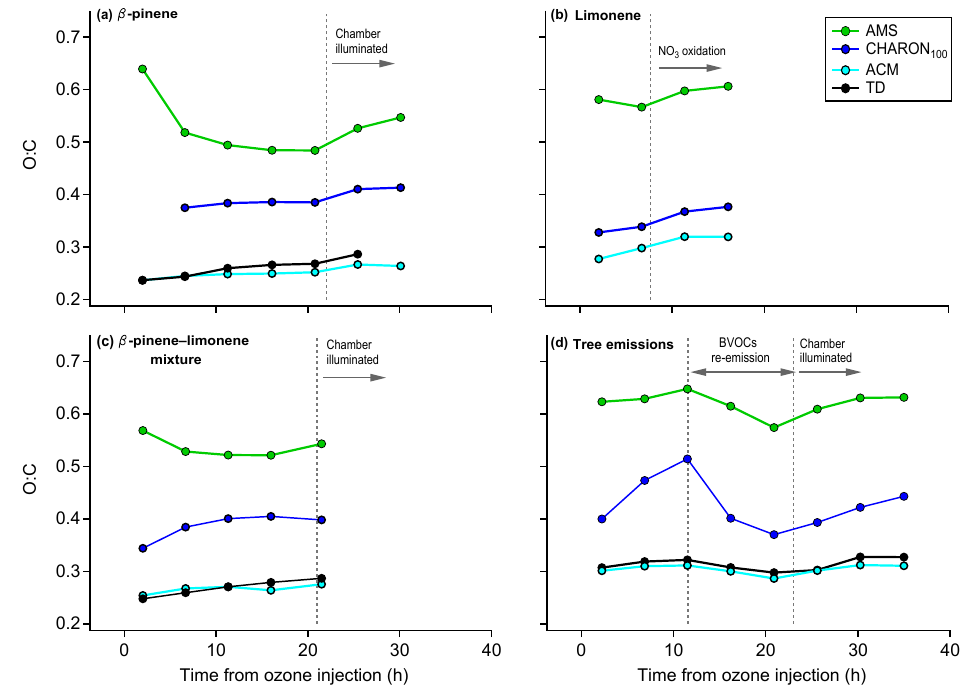
Figure 2. Bulk oxygen-to-carbon ratio comparison for the different instruments (CHARON 100 : blue; AMS: green; ACM: light blue; TD: black) versus the time from ozone injection. Experimental description details are provided in Table